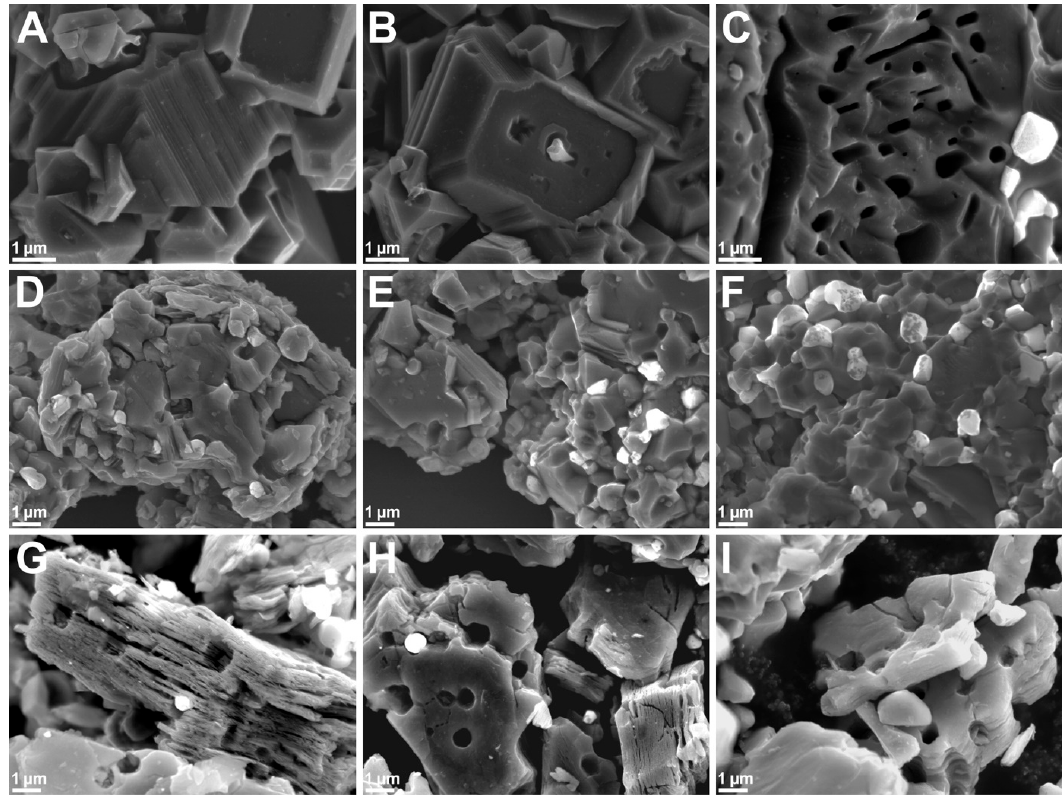
Figure 2. SEM micrographs of MAX phase pellets ( A – C ), ground powders ( D – F ) and purified MXene particles ( G – I ) prepared in Ar ( A , D , G ), Air ( B , E , H ) and O 2 ( C , F , I ) environments.